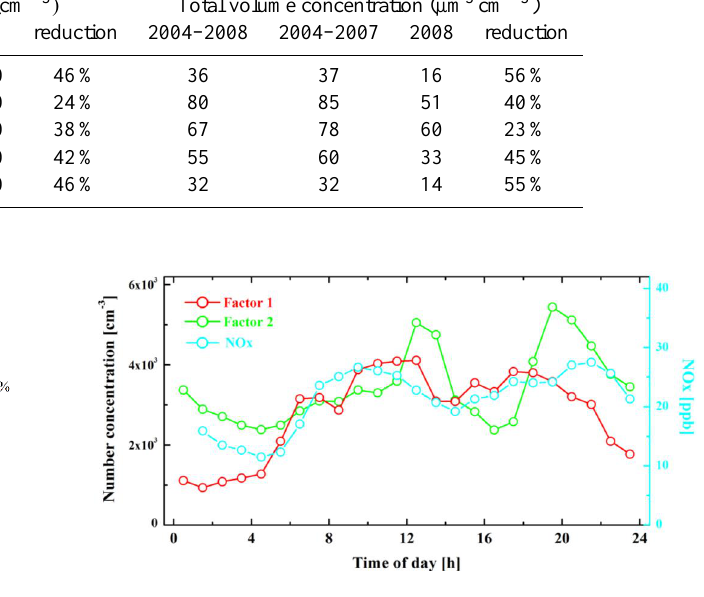
Figure 7: Diurnal variations of NOx (cyan) and particle number concentration of factor 1 (red) and factor 2 776 Fig. 7. Diurnal variations of NO x (cyan) and particle number con- (green). 777 centration of factor 1 (red) and factor 2